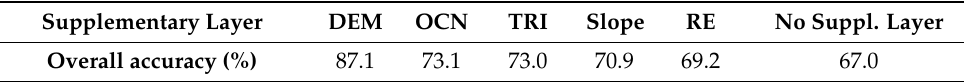
Table 3. Supplementary datasets. This table presents the overall accuracy values reached for different supplementary layers when used in combination with the RGB orthomosaic in the classification.